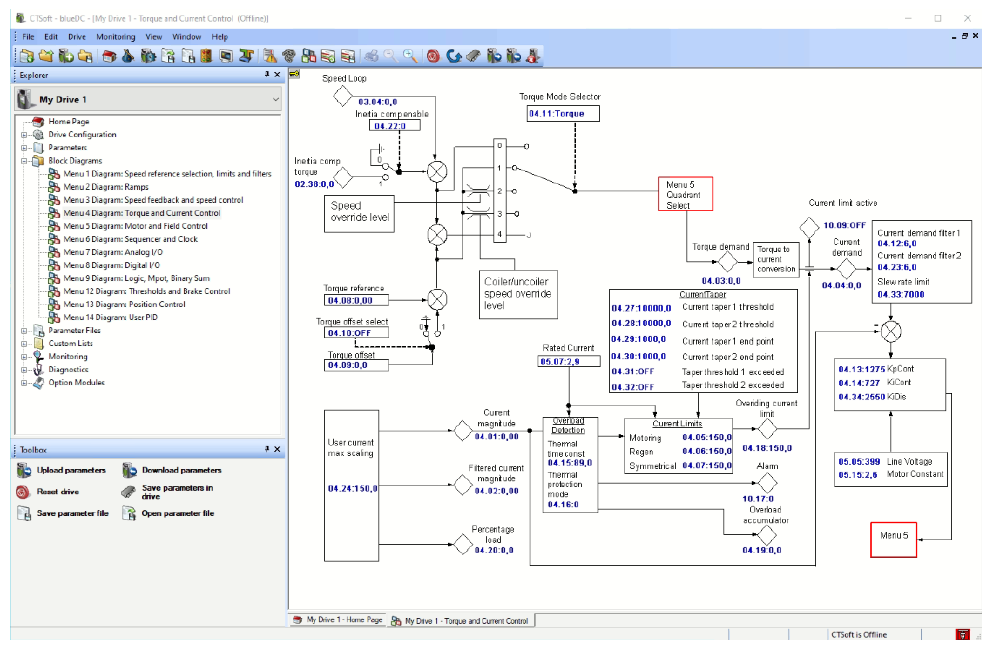
Figure 15. CTSoft application for Apator MENTOR.